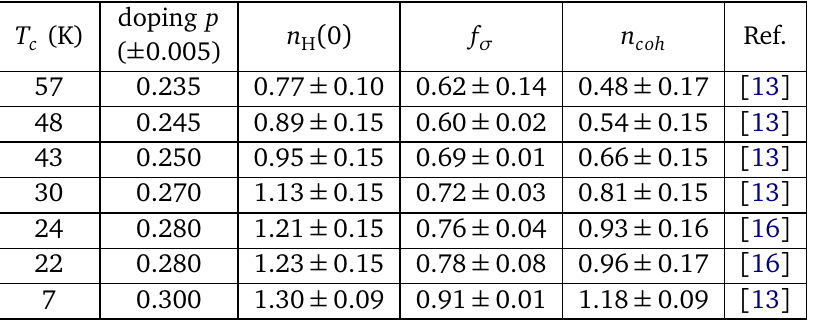
Table 2: Extracted coherent carrier densities in the zero-temperature limit for differ- ent doping levels in OD Tl2201. The measured Hall number n for each doping level from the grey dashed line in Fig. 4 based on Ref. [ 14 ] , while the weighting factor f σ was determined using Eq. (24) and the residual resistivity com- ponents listed in Table 1. Finally, Eq. (16) was used to obtain n f σ were calculated as composite deviations coming from standard deviations in re- sistivity parameters A and C and the error bars for n deviations coming from standard deviations in f σ and in n